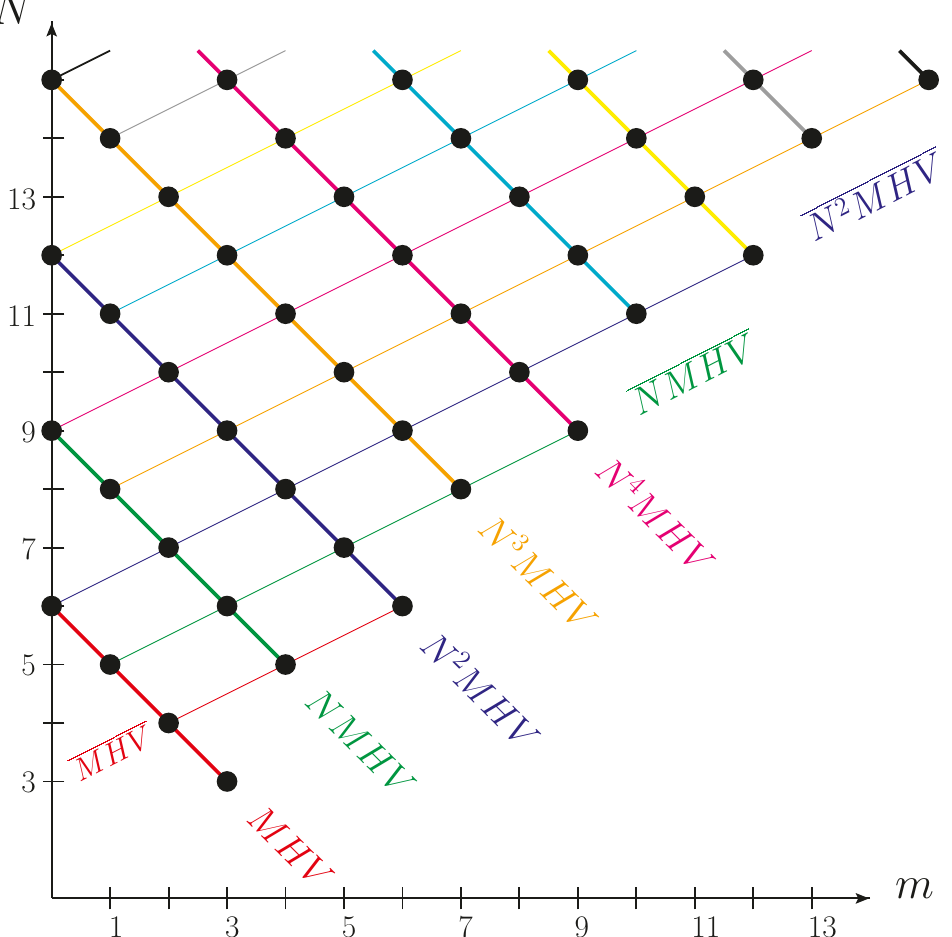
Figure 2 . N -point superamplitudes with m states (cid:22)(cid:8) and ( N symmetry. Points on the anti-diagonals represent the N k MHV amplitudes with R A = k ; points on the diagonals represent the conjugate amplitudes N k MHV. Amplitudes lying on the intersection of lines with the same k are self-conjugate. The MHV point ( N; m ) = (3 ; 3) is special, since its MHV conjugate has an exceptional